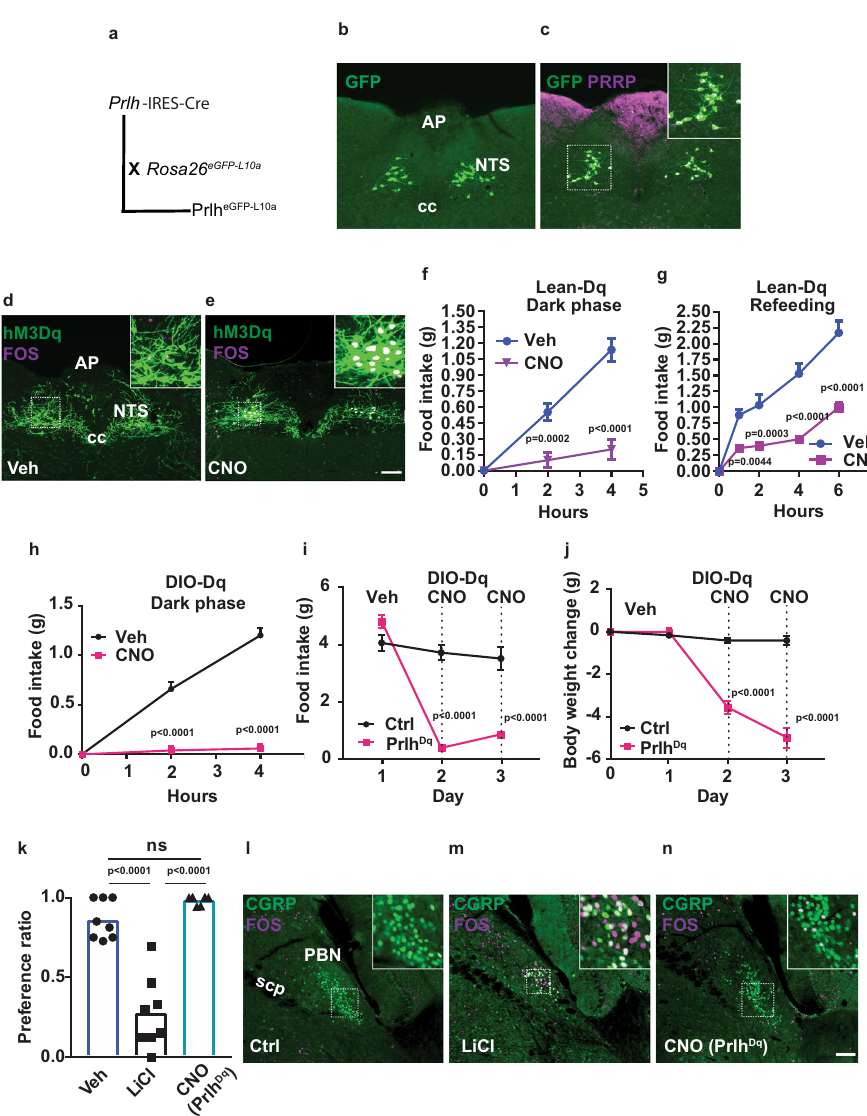
Fig. 1 Prlh cre mice reveal roles for Prlh NTS neurons in the control of food intake in lean and DIO mice. A Schematic diagram showing the Prlh Cre mouse strain and its breeding onto the ROSA26 eGFP-L10a background to generate Prlh eGFP-L10a reporter mice. B , C Representative images showing GFP-IR (green) alone ( B ) or together with PRRP-IR (magenta) ( C ) in the NTS of a Prlh eGFP-L10a reporter mouse. Inset in ( C ) shows digitally zoomed images of the boxed region. D , E Representative images showing mCherry-IR (hM3Dq, green) and FOS-IR (magenta) in the NTS of Prlh NTS-Dq mice following treatment with saline ( D , Veh) or CNO ( E , IP, 1 mg/kg) for 2 h before perfusion. F , G We examined food intake in chow-fed Prlh NTS-Dq mice over the fi rst 4 h of the dark phase ( F , n = 8 animals/group) and during the fi rst 6 h of refeeding in the light cycle following an overnight fast ( G , n = 7 animals/group) during treatment with CNO (IP, 1 mg/kg) or Veh. H DIO Prlh NTS-Dq mice were treated with Veh or CNO (IP, 1 mg/kg) immediately prior to the onset of the dark cycle and food intake was measured over the subsequent four hours. I , J DIO Control (Ctrl, n = 5 animals/group) or Prlh NTS-Dq (Prlh Dq , n = 6 animals/group) mice were treated with Veh for two baseline days, followed by two days with CNO (a single IP 1 mg/kg dose at the onset of the dark cycle followed by 3.33 mg/ ml in drinking water for the duration of treatment) and daily food intake ( I ) and body weight change from baseline ( J ) were determined. Vehicle (Veh) and CNO treatment are denoted on the graphs. K Mice were treated with vehicle (Veh), LiCl, or CNO (IP) during exposure to a novel tastant (HFD); their consumption of HFD given a choice between chow and HFD was determined the following day; n = 8 animals/group. L – N Representative images showing PBN FOS-IR (purple) and GFP-IR (CGRP, green) in control mice (Ctrl), mice treated with LiCl (IP, 126 mg/kg), or in Prlh NTS-Dq mice treated with CNO (IP, 1 mg/kg); all mice were on the CGRP GFP background 20 . Shown is mean + / − SEM. Two-way ANOVA, sidak ’ s multiple comparisons test was used; p values are shown for signi fi cant comparisons. All images taken at same magni fi cation; scale bar equals 150 µ m. ns: not signi fi cant vs Veh ( p > 0.05). All experiments were repeated in two independent cohorts of animals with similar results; cohorts were combined for publication. hM3Dq-mediated activation of these cells. As for Calcr NTS cells 4 , circuits as targets for the treatment of obesity. Furthermore, activation of Prlh NTS cells suppressed food intake in a variety of activating Prlh NTS neurons did not provoke a conditioned taste acute paradigms (Fig. 1F, G). The hM3Dq-mediated activation of aversion (CTA, Fig. 1K), and poorly promoted FOS-IR in aversive Prlh NTS cells also suppressed food intake and decreased body CGRP PBN neurons (FOS + CGRP/CGRP: Veh- 2 + / − 0.3%; weight over multiple days in diet-induced obese (DIO) mice LiCl- 37 + / − 9% ( p = 0.0115 vs Veh); CNO- 9 + / − 4% (Fig. 1H – J), consistent with the potential utility of Prlh NTS ( p = 0.5925 vs Veh), n = 3 animals/group) (Fig. 1L – O). NATURE COMMUNICATIONS| (2021) 12:5175